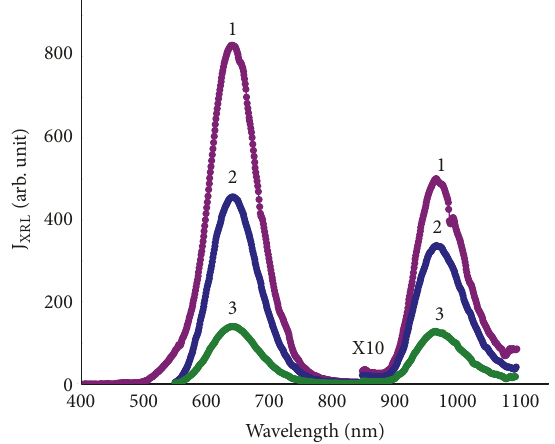
Figure 2: The distinctive XRL spectra of the ZnSe single crystal at the temperature of 85 K under different levels of excitation: the current of the X-ray tube, 25mA (1) ; 15mA (2) ; and 5mA (3) (the XRL intensity is multiplied by 10 for the 970 nm band).